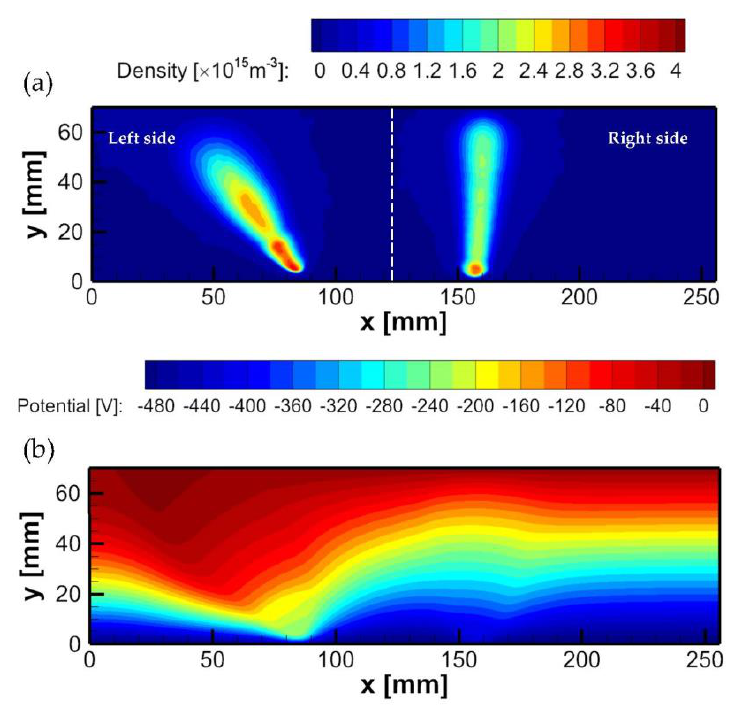
Figure 9. ( a ) Plasma density and ( b ) electric potential of the asymmetric magnetic flux density shown